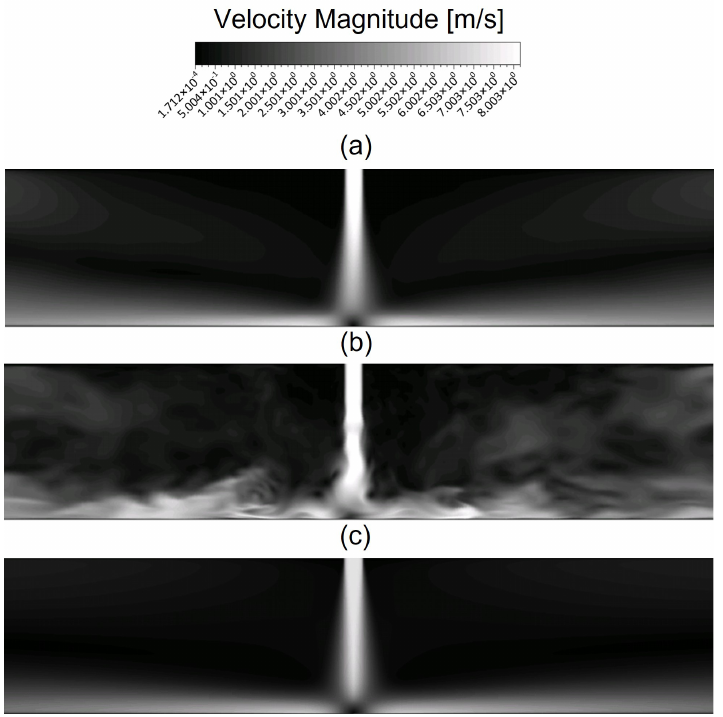
Figure 19. Velocity magnitude contours for ( a ) LES time-averaged, ( b ) LES instantaneous, and ( c ) RANS turbulence